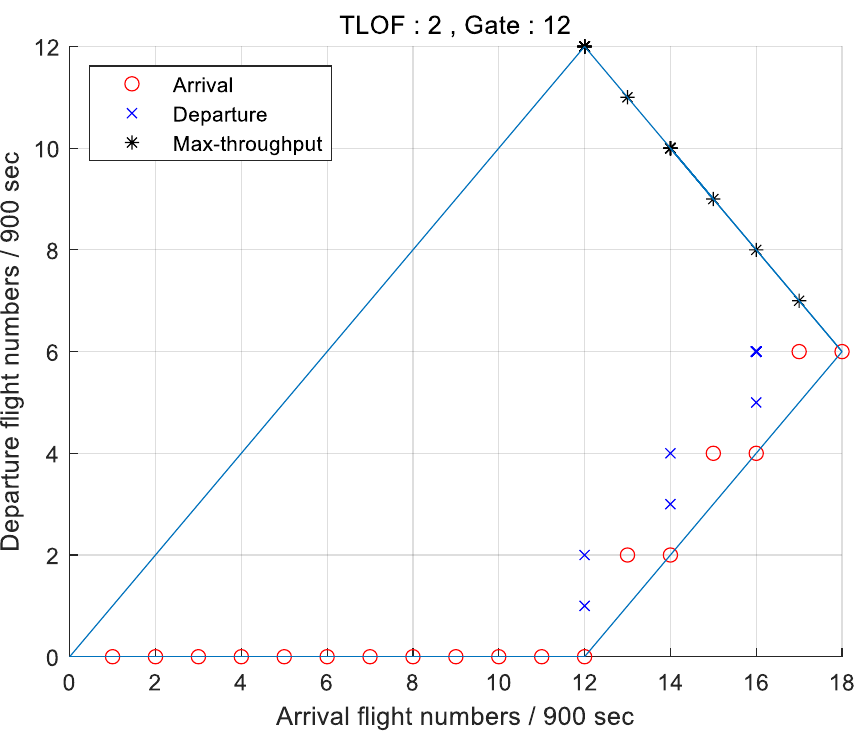
Figure 28. The satellite topology capacity of the current Gimpo Airport parking lot that complies with the FAA’s new regulations : ( a ) 1 TLOF, 3 Gates; ( b ) 1 TLOF, 4 Gates.